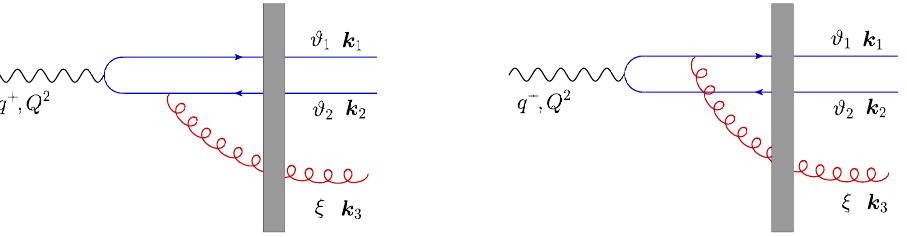
Figure 3 . Feynman graphs representing the amplitude for the scattering between the q ¯ qg system and the nuclear target (represented as a shockwave) in the case where the gluon emission occurs before the scattering.